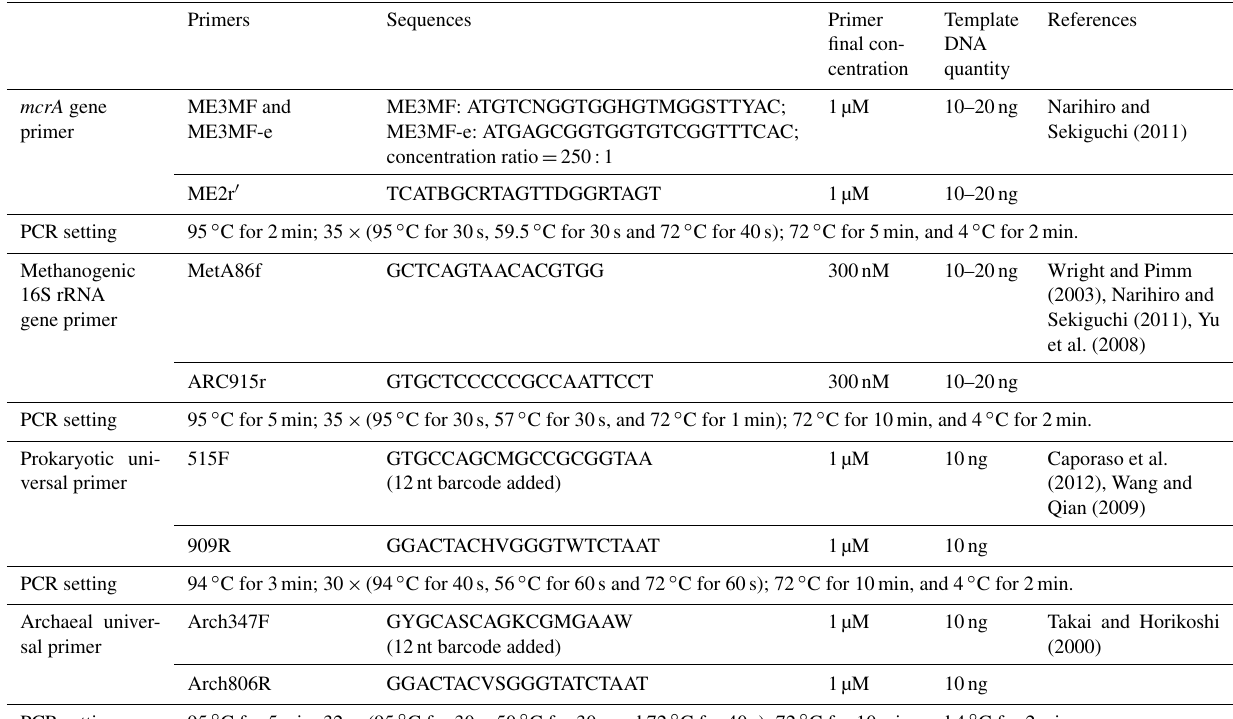
Table 2. PCR primers and PCR